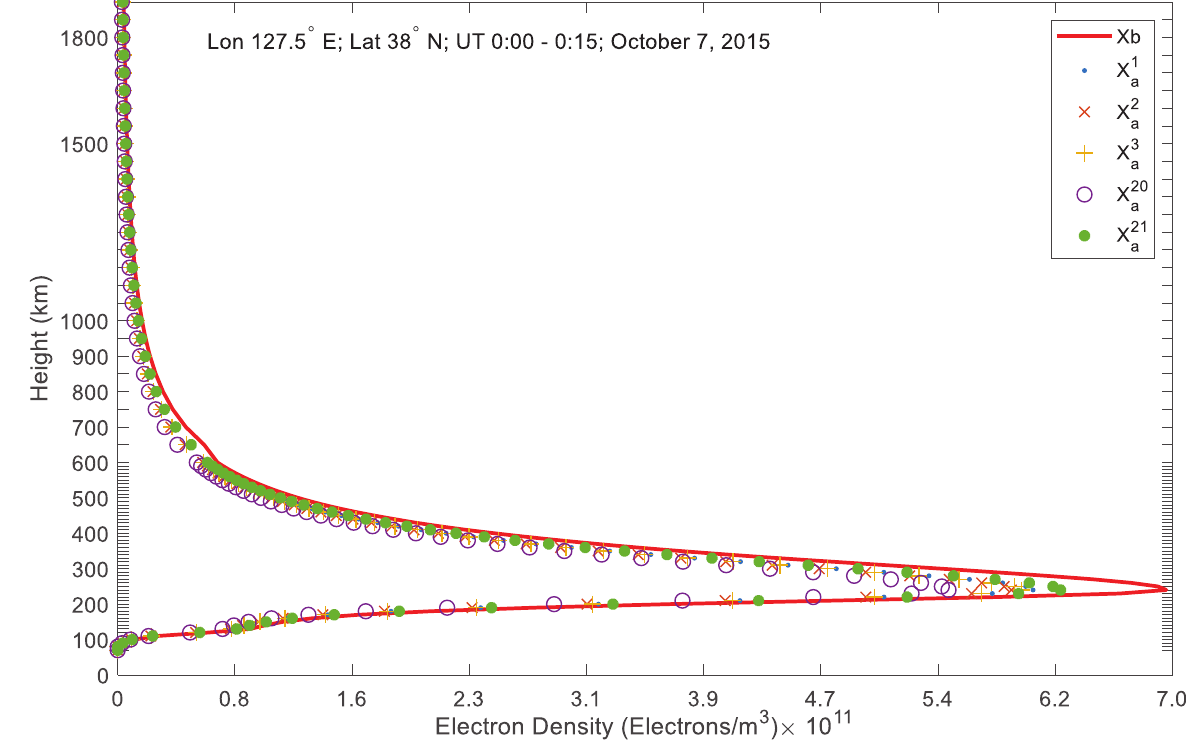
Figure 3. Electron density pro fi le obtained from NeQuick model (red) and improved pro fi les (., (cid:5) , +, o, *) associated with assimilation of some TEC values within spatial grid cell centered at longitude and latitude 127.5 (cid:3) E and 38 (cid:3) N, respectively. The date and time interval associated with the data plotted are indicated on top of the